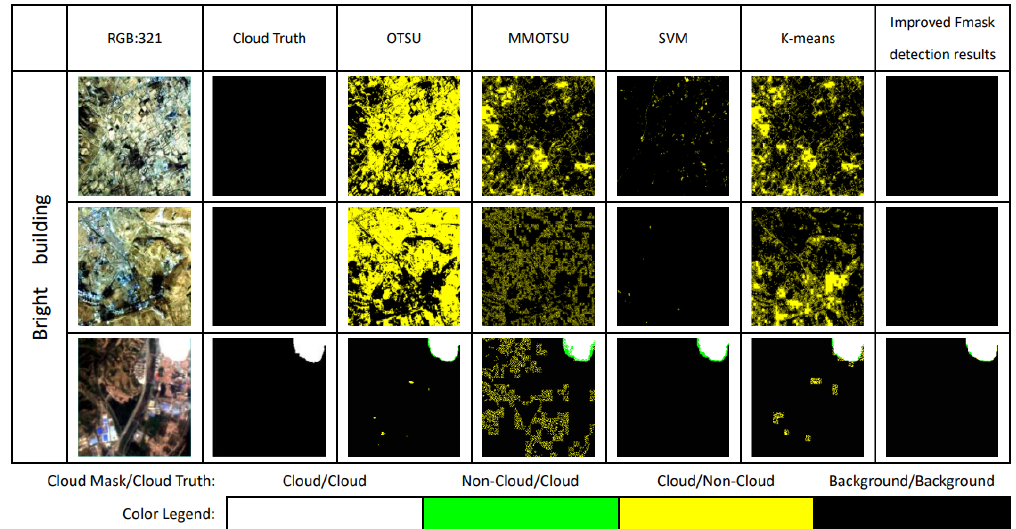
Figure 8. Comparison of the results of different cloud detection methods for images of bright building on the underlying surface. The first image in each row shows a subset of GF-6 WFV data (Bands 3, 2, and 1 composite). The second image in each row shows the distinction of the first image into cloud (white) and background (black) through visual interpretation. The third to seventh pictures in each row show the results of testing the same data by different methods, such as OTSU. Among them, the yellow represents what was actually non-cloud but was detected as cloud (commission errors), and the green represents what was actually cloud but was detected as non-cloud (omission errors).